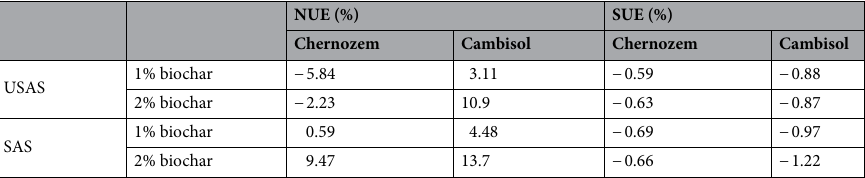
Table 3. The effect of biochar on the use efficiency of nitrogen (NUE) and sulphur (SUE). Nutrient use efficiency in percentage calculated per added amount of N and S from